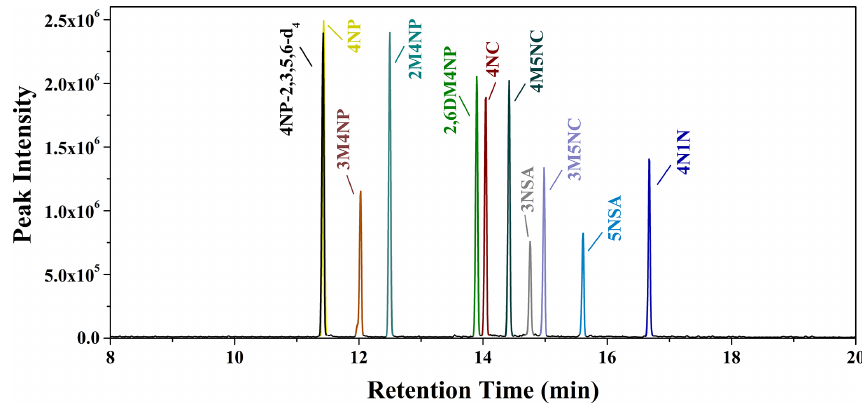
Figure 1. Selected ion-monitoring chromatograms for the nitrated-aromatic-compound standards (2µgmL − 1 ; 4NP-2,3,5,6-d 4 : 4- nitrophenol-2,3,5,6-d 4 ; 4NP: 4-nitrophenol; 3M4NP: 3-methyl-4-nitrophenol; 2M4NP: 2-methyl-4-nitrophenol; 2,6DM4NP: 2,6-dimethyl- 4-nitrophenol; 4NC: 4-nitrocatechol; 4M5NC: 4-methyl-5-nitrocatechol; 3NSA: 3-nitrosalicylic acid; 3M5NC: 3-methyl-5-nitrocatechol; 5NSA: 5-nitrosalicylic acid; 4N1N: